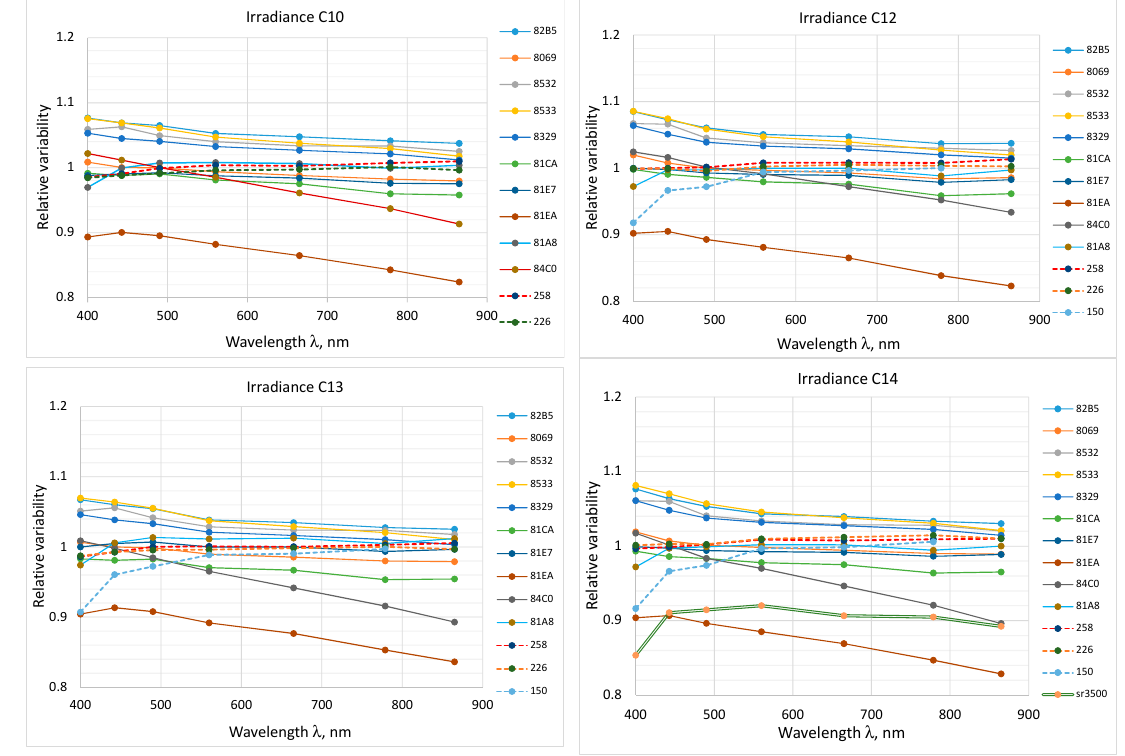
Figure 10. Irradiance sensors compared to the consensus value. Solid lines—RAMSES sensors; dashed lines—HyperOCR sensors; double line—SR-3500.